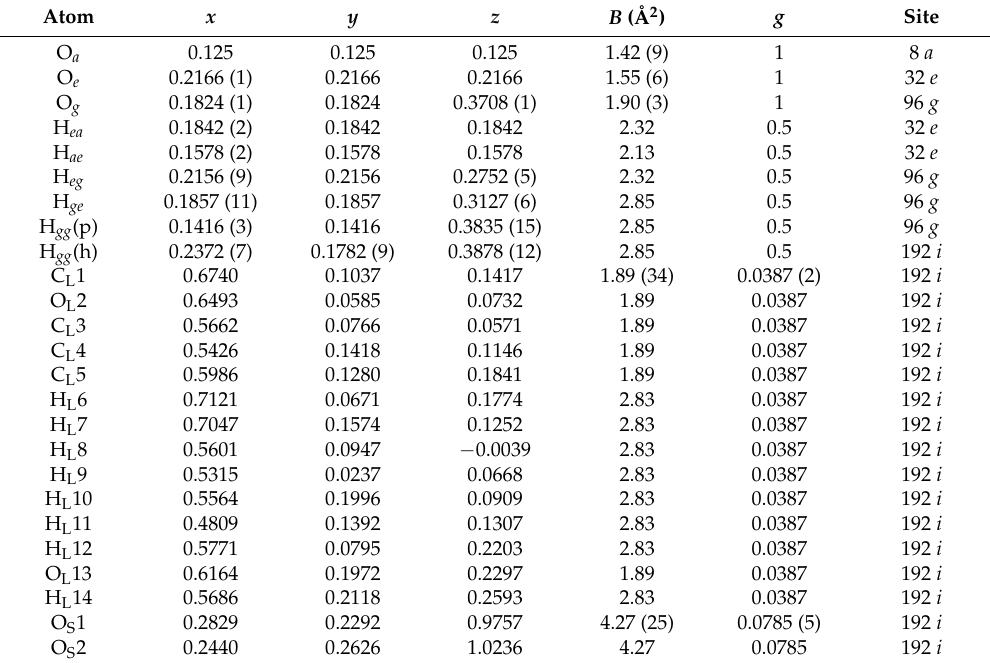
Table 2. Atomic coordinates and isotropic temperature factors for 3-hydroxytetrahydrofuran (3-OH THF) + O 2 hydrate at 100